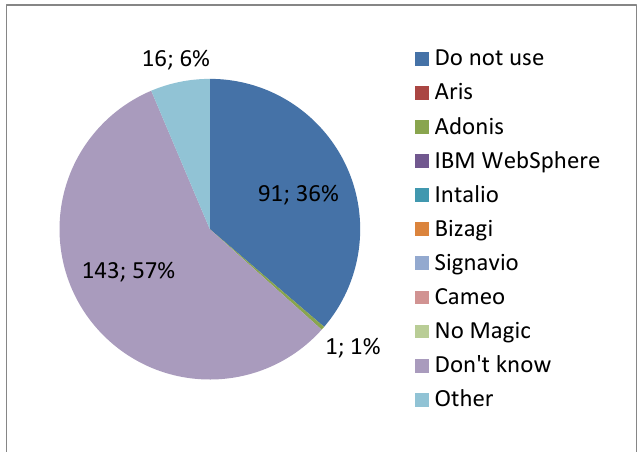
Fig.4. BP modeling tool used in institutions.